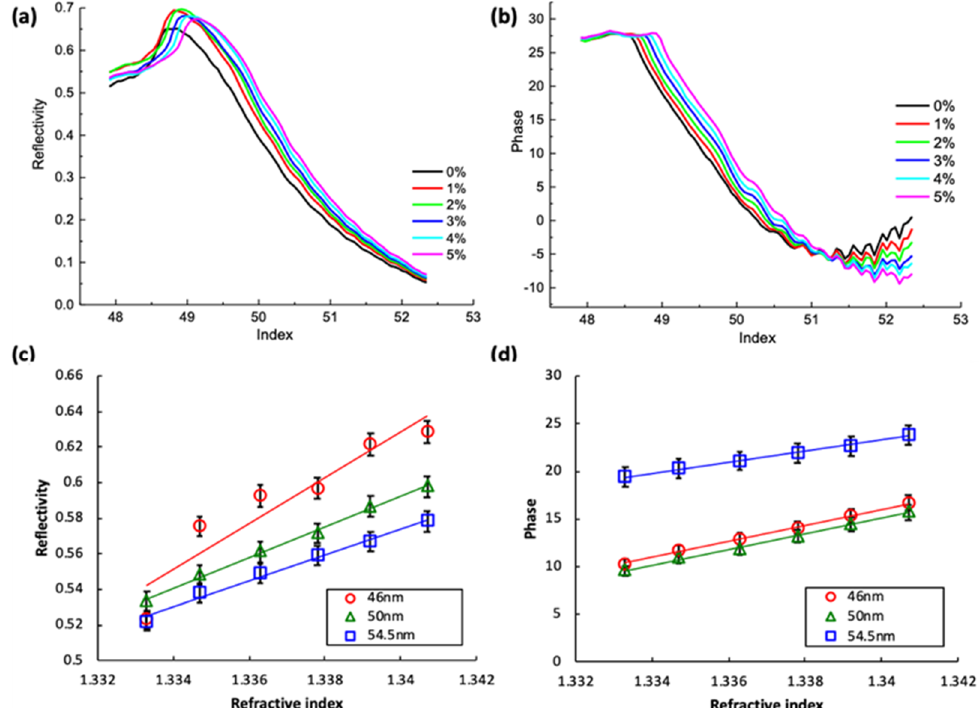
Figure 5. ( a ) Reflectivity and ( b ) phase differences with various incident angles for various concentrations of glucose solution. The thickness of the deposited TiN layer is 46 nm. ( c ) Reflectivity and ( d ) phase for various refractive indexes (real part) of glucose solution using samples with various TiN layer thickness.